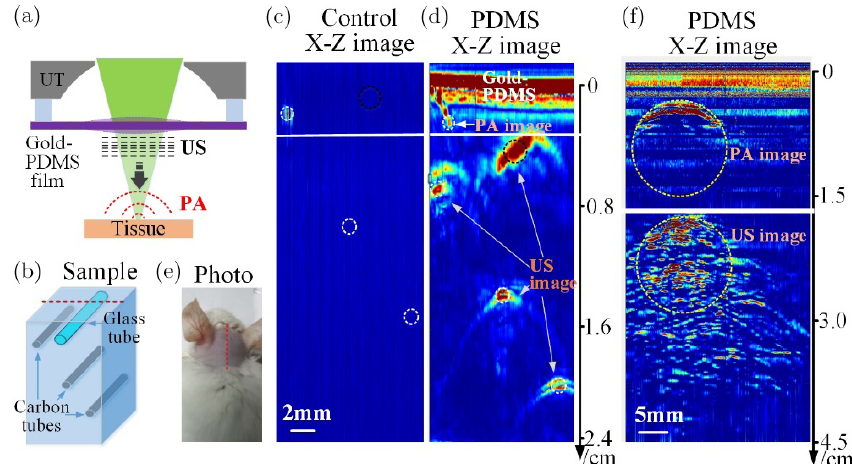
Fig. 6. Simultaneous PA/US images of a tissue-mimic phantom sample and a mouse brain model. (a) Schematic diagram of simultaneous PA/US imaging based on a °at gold-PDMS ¯lm. (b) Schematic diagram of the tissue-mimic phantom sample. (c) and (d) are the obtained PA and US images in x – z plane corresponding to the red line in (b) for the case of without and with a gold- PDMS ¯lm. (e) The photo of the mouse model. (f) The PA and US images PA imaging of a mouse brain in x – z plane along the red line in